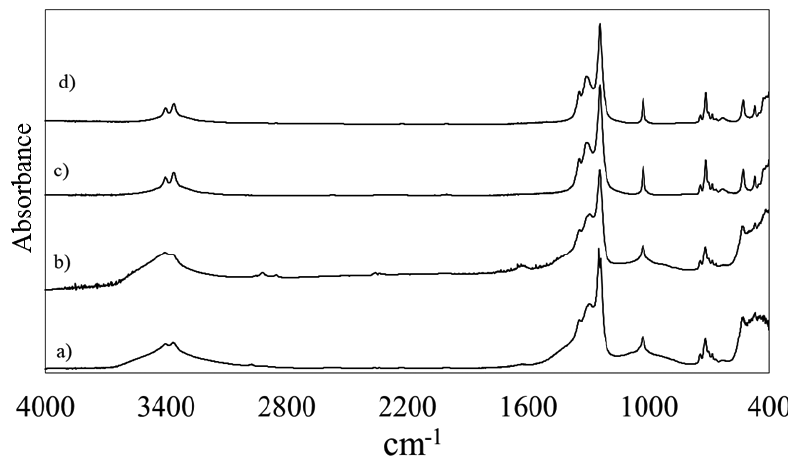
Figure 2: FTIR spectra of solid products synthesized at 110°C, and for different reaction time: a) 3 h, b) 4 h, c) 5 h, and d) 6